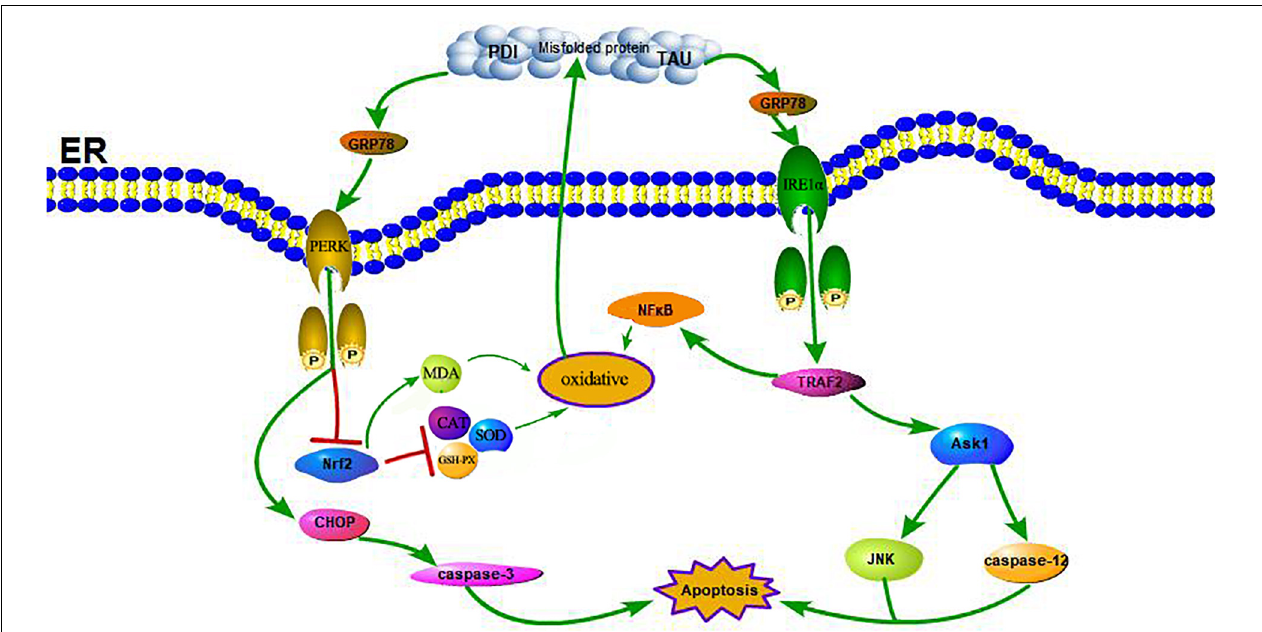
FIGURE 7 | Schematic illustration of the DM-induced ERS and OS. DM induced apoptosis through activation of the signaling pathway IRE1 α , TRAF2, ASK1, JNK, caspase-12, and the pathway PERK, CHOP, caspase-3. Meanwhile, the reduction of Nrf2 induced by activation of PERK and the increase of NF κ B induced by activation of TRAF2 contribute to enhance oxidative stress, further lead to a increase of PDI, p-TAU and accumulation of misfolded proteins which in turn increased the activation of the receptor IRE1 α and PERK.